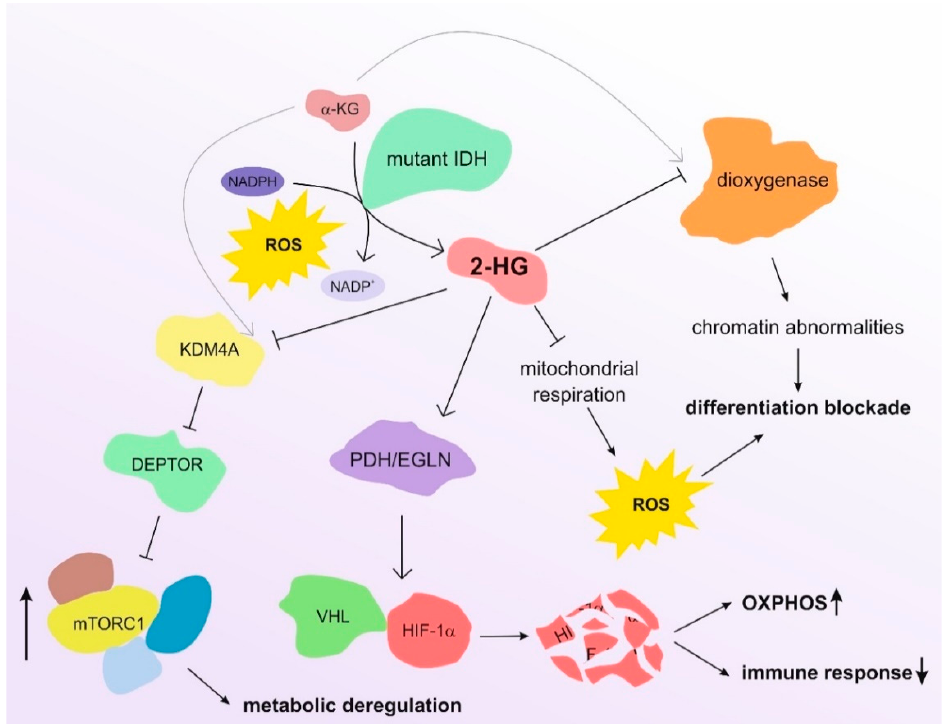
Figure 2. Main molecular effects of 2-HG in AML cells. The reduction of α -KG to 2-HG by mutated IDH enzymes leads to profound alterations in the biology of AML cells. The inhibition of α -KG- dependent dioxygenases–such as TET2 [33]—alters the chromatin architecture, thus rewiring gene expression and inducing differentiation blockade. Moreover, 2-HG leads to metabolic deregulation through the activation of the mTOR pathway and the inhibition of the HIF pathway. The increase in ROS levels resulting from NADPH consumption and altered mitochondrial respiration contributes to the blockade of differentiation and the aggressiveness of AML blasts.